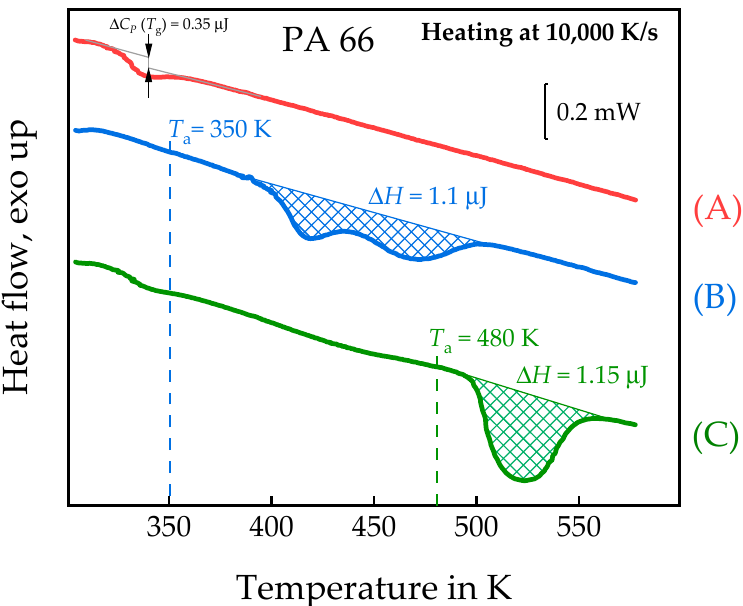
Figure 13. FSC melting curves of PA 66: ( A )—quenched sample, ( B )—annealed at 350 K for 1,000 s, ( C )—annealed at 480 K for 1,000 s.